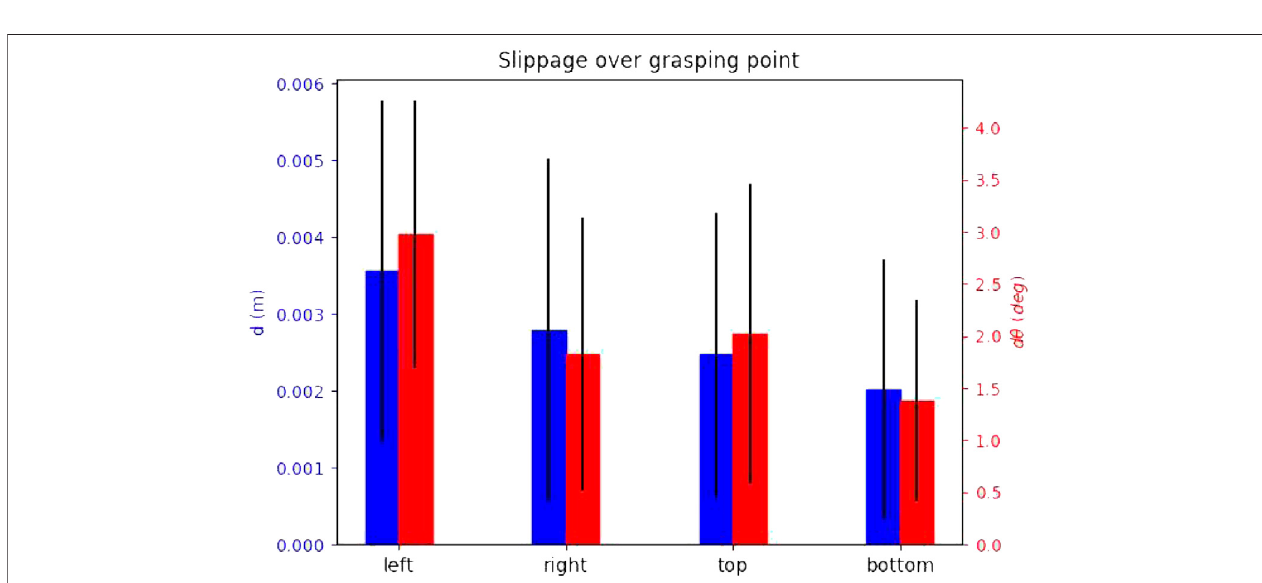
FIGURE 11 | The effect of the grasping point on stability for the simulation